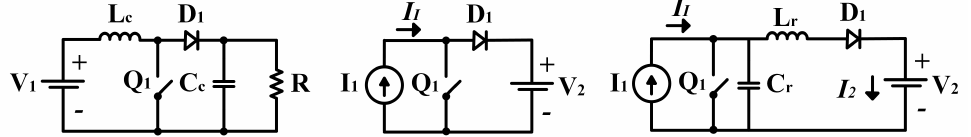
Figure 4. Boost converter : ( left ) common structure, ( middle ) steady-state equivalent circuit, and ( right ) ZVS quasi-resonant converter.